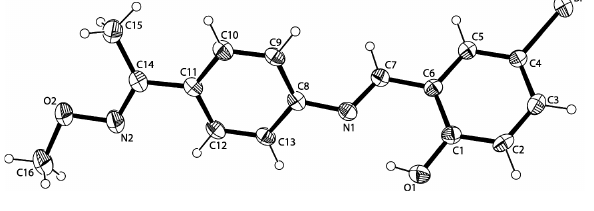
Table 1: Data collection and